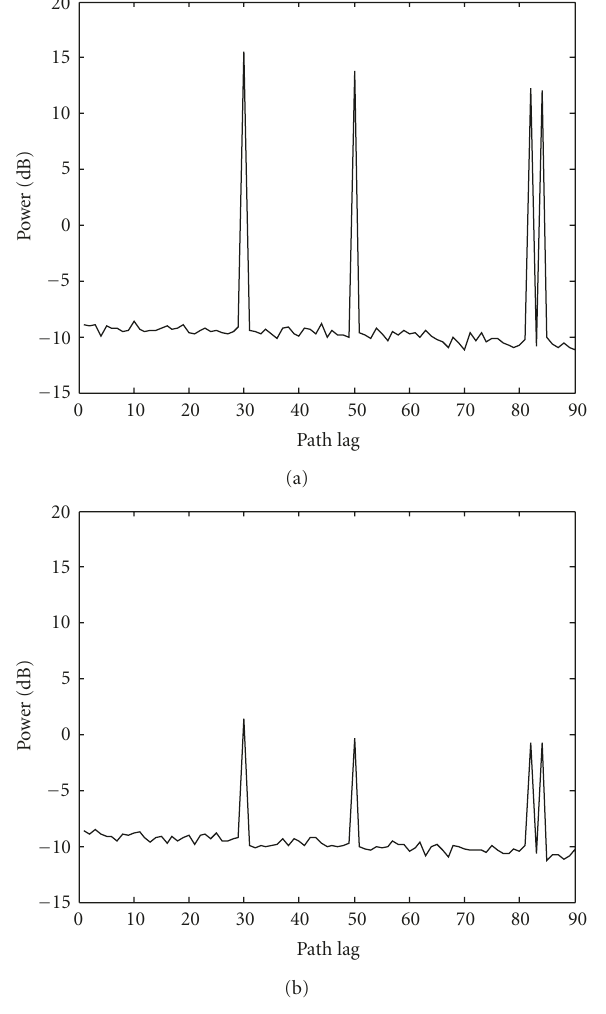
Figure 2: (a) Multipath lag finder spectrum when the look direction is the broadside with snr 1 = 7dB . (b) Path lag finder spectrum when the look direction is the broadside with snr 1 = − 10 dB .